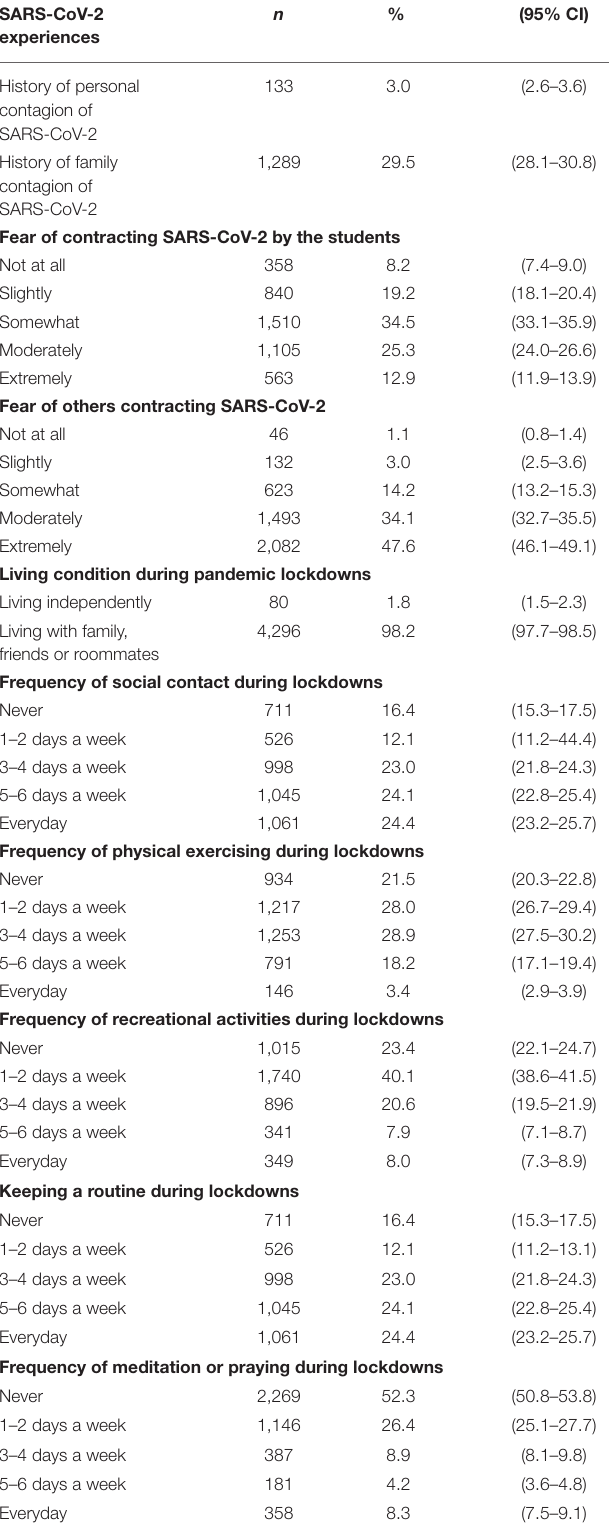
TABLE 5 | SARS-CoV-2 experiences